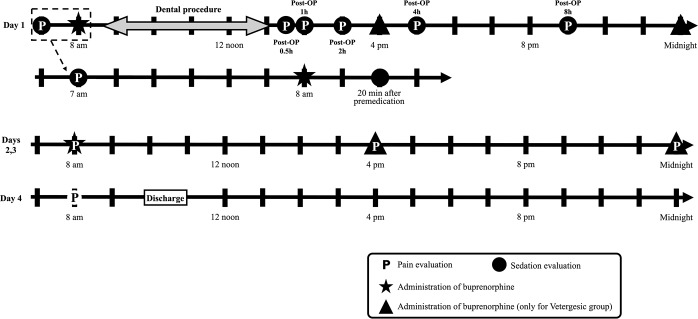
Schematic of time points for administration of buprenorphine during the study.The timeline demonstrates and example of a 4-hour dental procedure in a cat including time points of pain and sedation assessment.